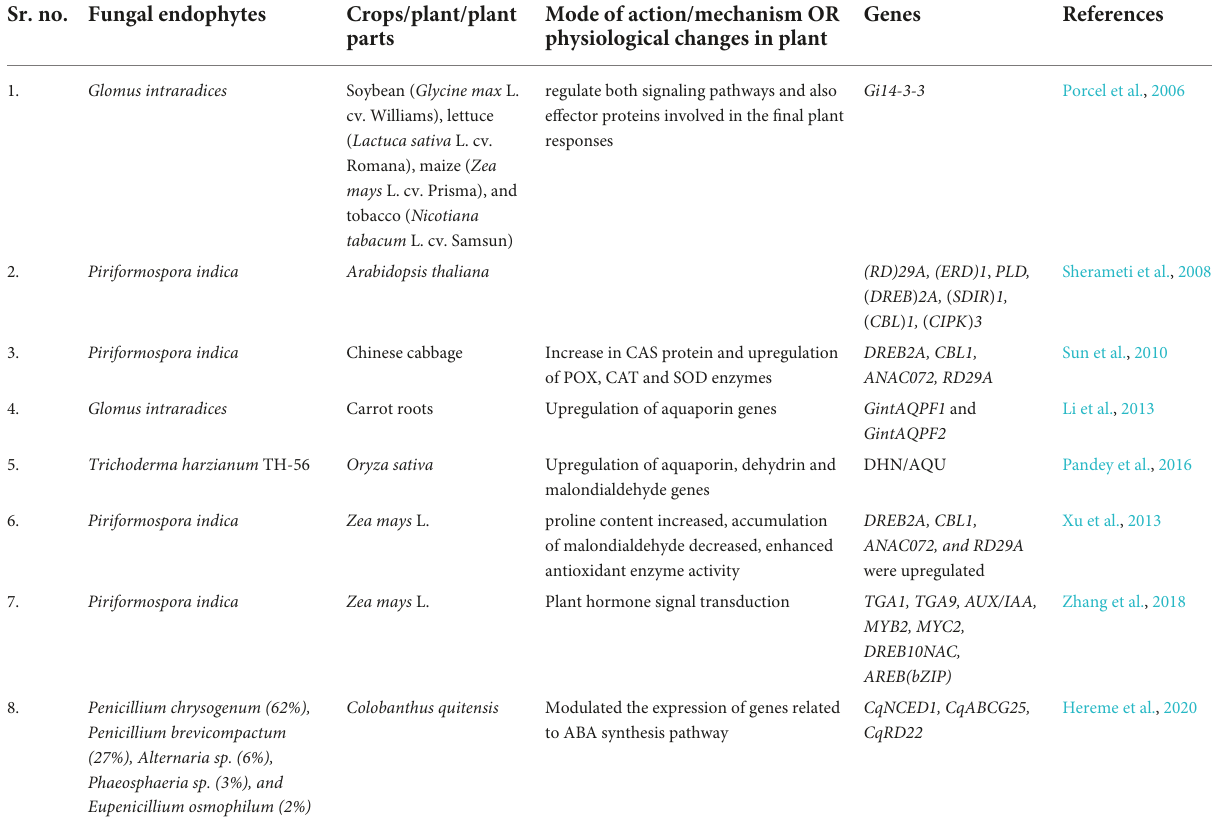
TABLE 2 Utilization of fungal endophytes to improve stress tolerance response of host